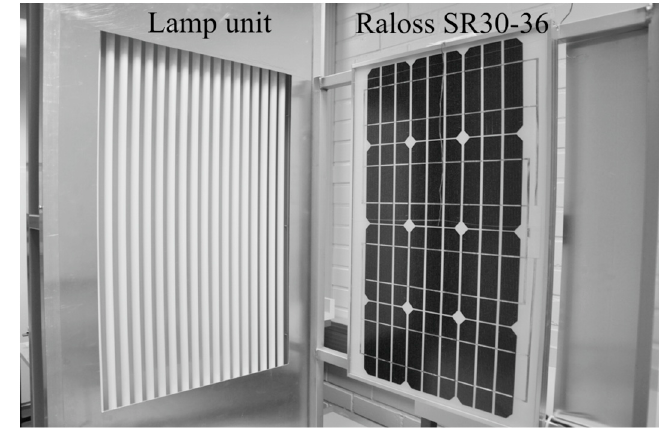
Figure 4. The artificial lamp unit with Raloss SR30-36 PV panel.